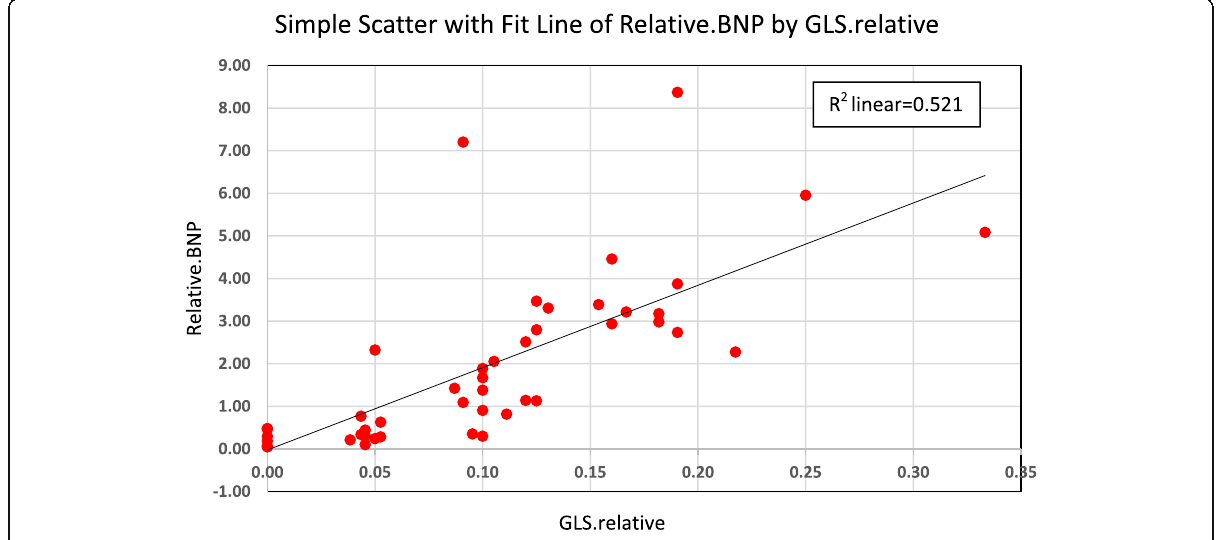
Fig. 1 The correlation between the relative change of NT-proBNP and the relative change of LV-GLS ( r = 0.833 and p <